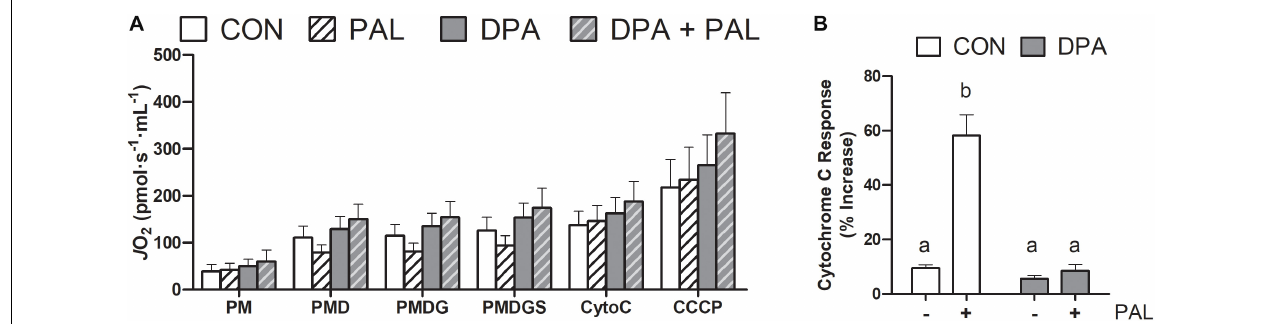
FIGURE 5 | Treatment with DPA and/or PAL does not alter mitochondrial respiration, but DPA maintains mitochondrial membrane integrity in response to PAL. In (A) , J O 2 represents mitochondrial O 2 flux. Cytochrome c retention test response expressed as (PMDGS-CytoC/CytoC) × 100 (B) . Treatments that do not share letters are considered statistically significant ( p < 0.05). Myoblasts were cultured and harvested independently to generate a total sample size of 4 biological replicates. Values are presented as mean ± SEM.